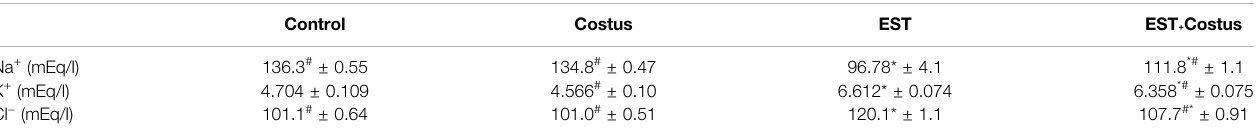
TABLE 2 | Effect of costus treatments on electrolytes levels in the different groups studied.